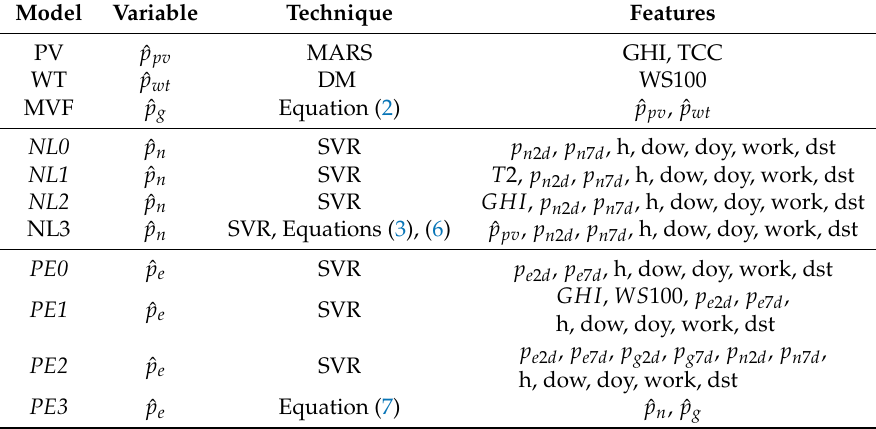
Table 2. Models and feature set for each forecast model. The first column represents the distinguishing abbreviation of the model; in the second column, the forecast variable is indicated; in the third column, the predictive technique used; and finally in the fourth column, the predictors used are listed. PV: photovoltaic forecast model; WT: wind turbine forecast model; MVF: forecast system for the medium voltage production; NL: denotes net load models; PE: denotes power exchange models; ˆ p pv : forecast of MV photovoltaic production; ˆ p wt : forecast of MV wind turbine production; ˆ p g : forecast of total MV power production; ˆ p n : forecast of LV net load; ˆ p e : forecast of power exchange; MARS: multivariate adaptive regression spline; DM: distribution mapping; SVR: support vector machine regression; GHI: Global Horizontal Irradiation; TCC: total cloud cover; WS100: wind speed at 100 m; T2: forecast of the temperature 2 m above ground; h: the hour of the day; dow: decimal for the day of the week; doy: days from the beginning of the year; work: indicates whether the day of the measure or forecast is a working day or not (including holidays); dst: indicates whether the time is relative to the period in which daylight saving is active; p n 2 d and p n 7 d : net load 2 days and 7 days before the forecast; p e 2 d and p e 7 d : power exchange 2 days and 7 days before the forecast; p g 2 d and p g 7 d : power generated by the MV plants 2 days and 7 days before the